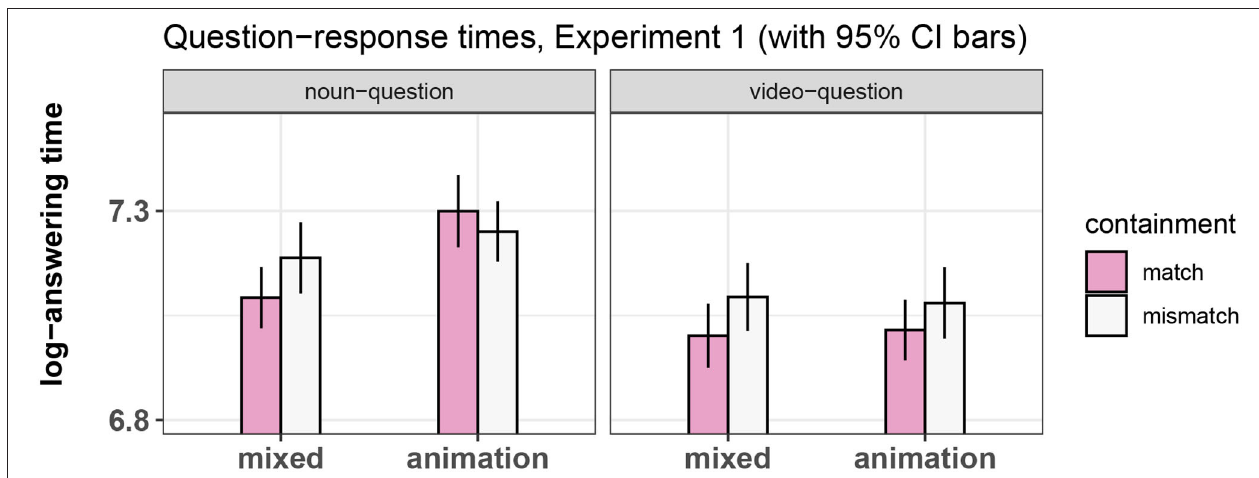
FIGURE 6 | Summary of results for the question response time, Experiment